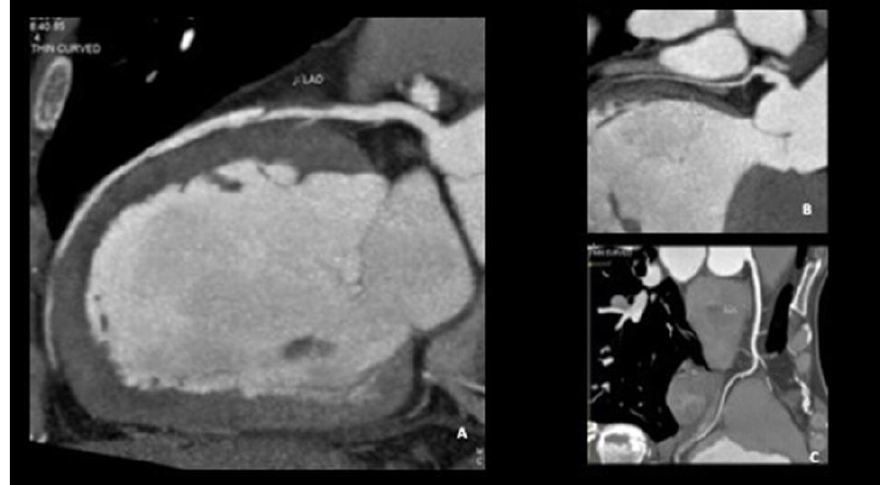
Figure 4. Coronary CT of a 42-year-old woman with STEMI, showing SCAD of the middle tract of LAD ( A ) and normal morphology of left circumflex ( B ) and right coronary artery ( C ). CT: computer tomography; STEMI: ST-elevation myocardial infarction; SCAD: spontaneous coronary artery dissection; LAD: left anterior descending.